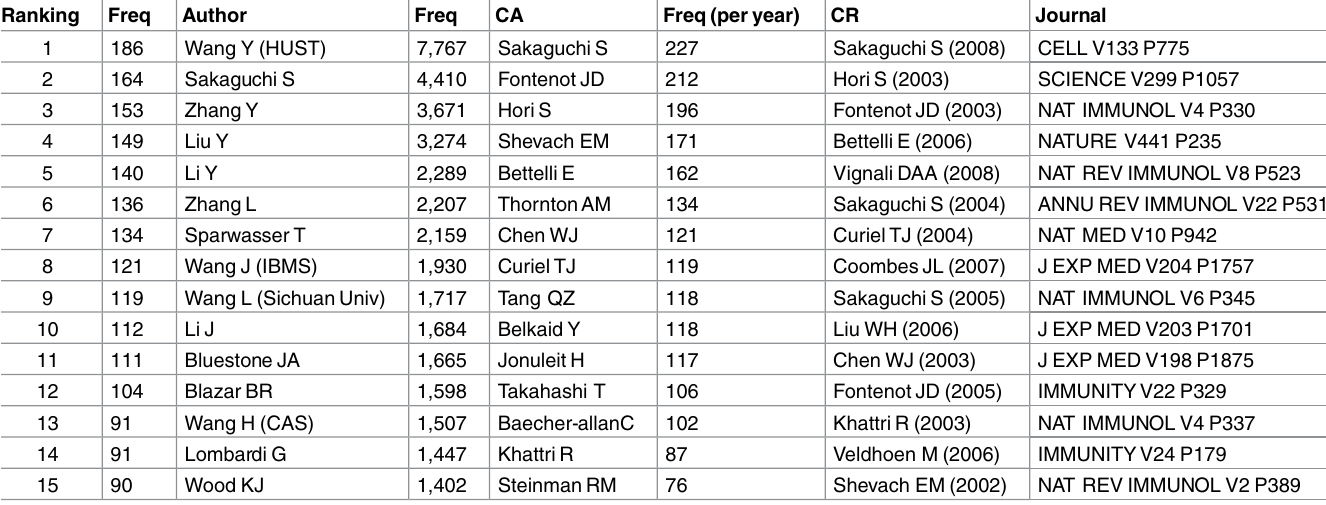
Table 4. The top 15 activeauthors,citedauthors(CA),and citedreferences (CR)in regulatory T cell (Treg) research from 2000 to